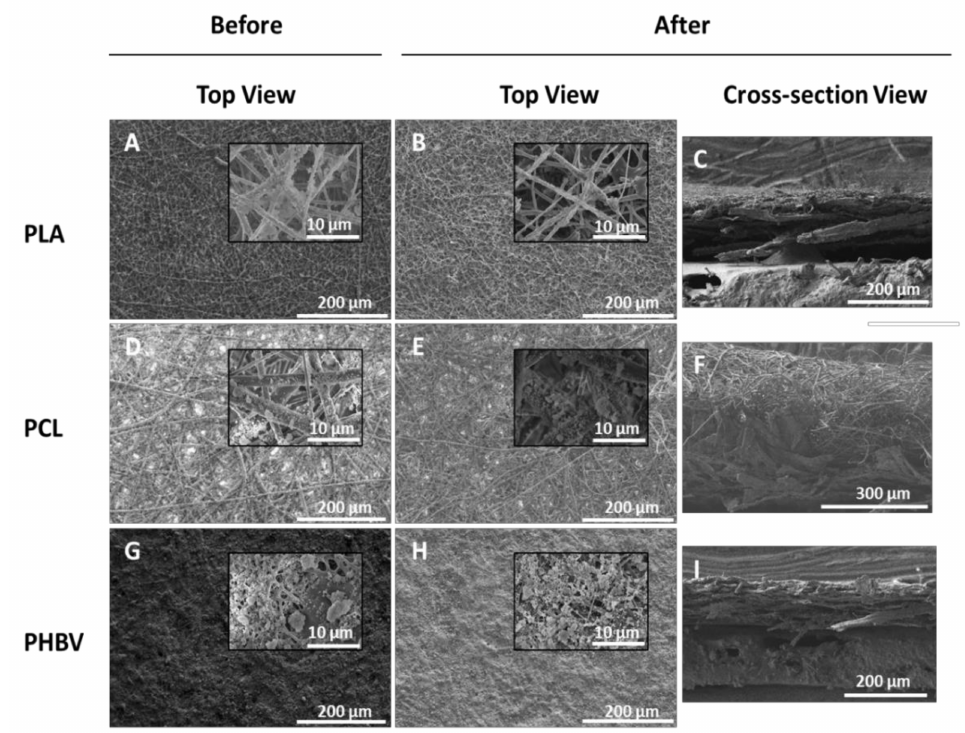
Figure 8. Top and cross-section views images by field emission scanning electron microscope (FE-SEM) before and after performing the tape peel-off adhesion test of the multilayer struc- tures based on paper, electrospun polylactide (PLA), poly( ε -caprolactone) (PCL), and poly(3- hydroxybutyrate-co-3-hydroxy-valerate) (PHBV) mats, and electrosprayed hydrophobic silica mi- croparticles: ( A – C ) Paper/PLA/SiO 2 annealed at 160 ◦ C; ( D – F ) Paper/PCL/SiO 2 annealed at 55 ◦ C; and ( G – I ) Paper/PHBV/SiO 2 annealed at 120 ◦ C. Table 6. Apparent water contact angle (WCA) and sliding angle (SA) of the multilayer struc- tures based on paper, electrospun polylactide (PLA), poly( ε -caprolactone) (PCL), and poly(3- hydroxybutyrate-co-3-hydroxy-valerate) (PHBV) mats, and electrosprayed hydrophobic silica mi- croparticles before and after the tape adhesion test of Paper/PLA/SiO 2 annealed at 160 ◦ C, Paper/PCL/SiO 2 annealed at 55 ◦ C, and Paper/PHBV/SiO 2 annealed at 120 ◦ C. Before After Sample WCA ( ◦ ) SA ( ◦ ) WCA ( ◦ ) SA ( ◦